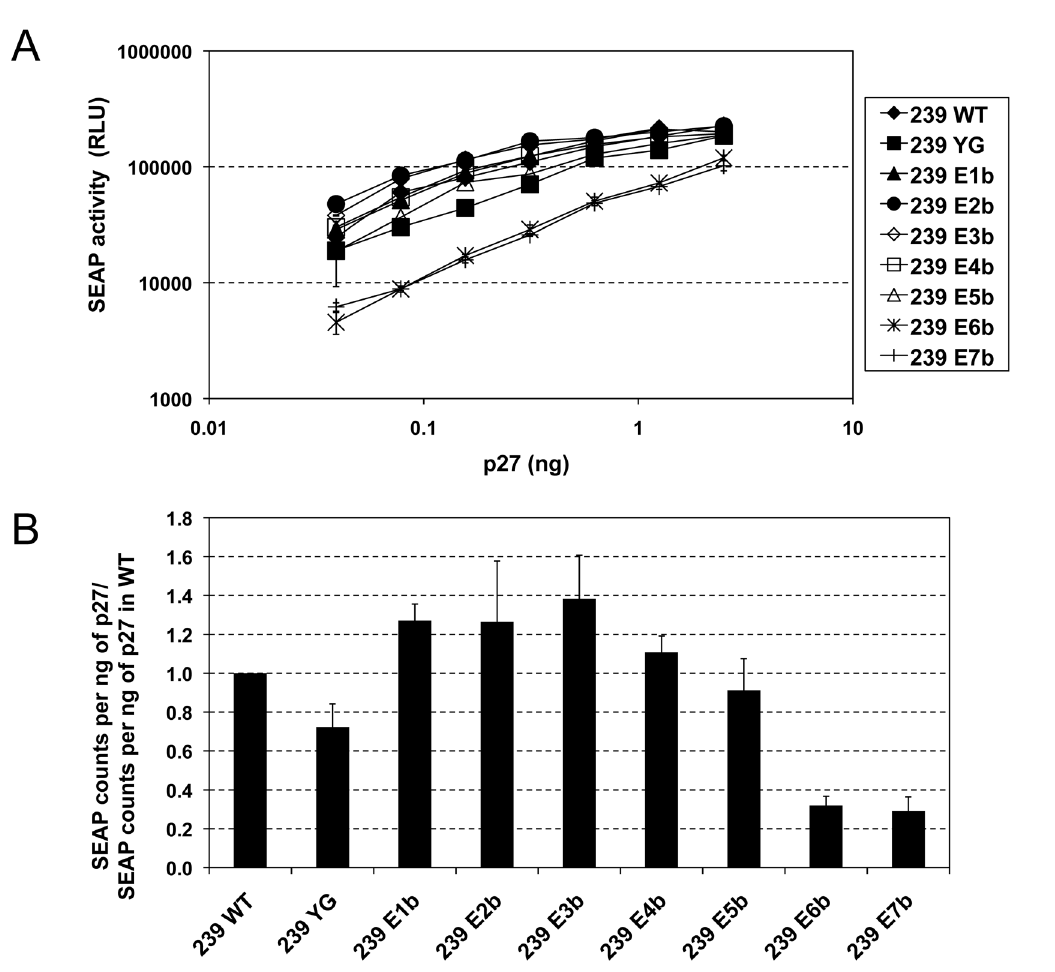
Figure 5. Viral infectivity of SIVmac239 is not affected by mutation of most potential trafficking motifs in gp41CD. Viruses were produced by transfection of HEK293Tcells and virions were pelleted from the clarified supernatants. Stocks were normalized for p27 content and used to infect C8166-45 SIV-SEAP cells with serial dilutions. ( A ) SEAP activity 3 days after infection. Error bars indicate standard deviation of triplicates. ( B ) SEAP activity per ng of p27 input, normalized for wild-type virus. Average of 2–3 independent experiments, error bars indicate standard deviation. WT, wild-type. SEAP, secreted alkaline